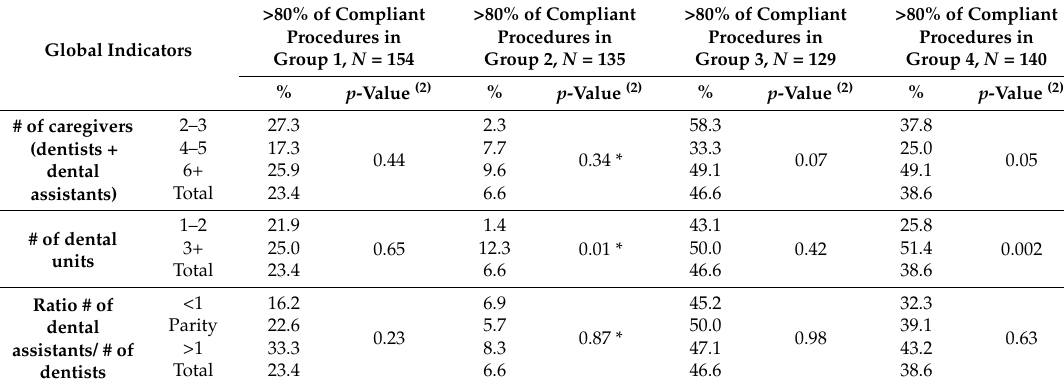
Table 5. Global adherence (>80%) to the four procedure groups (1) according to the characteristics of dental